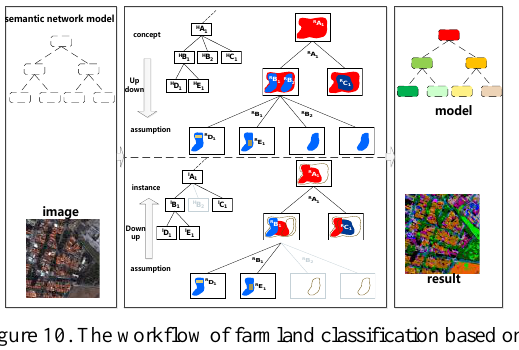
Figure 10. The workflow of farmland classification based on semantic network model and hybrid learning （ A 、 B 、 C